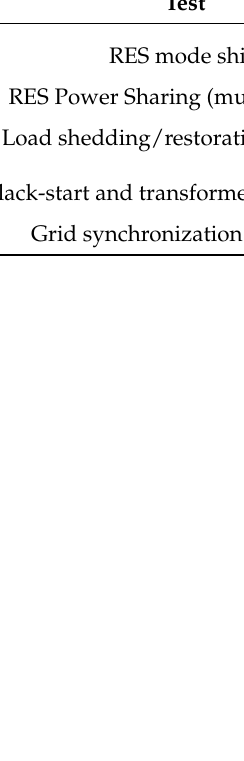
Table 1. EMS design verification tests.